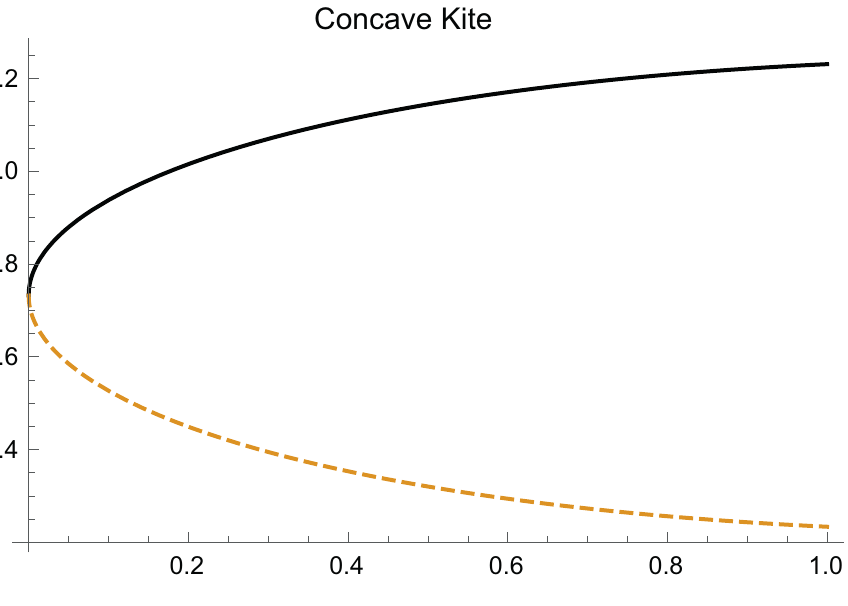
Fig. 1 Graph of functions y 3 ( m ) (continuos line) and y 4 ( m ) (dashed line), for m >